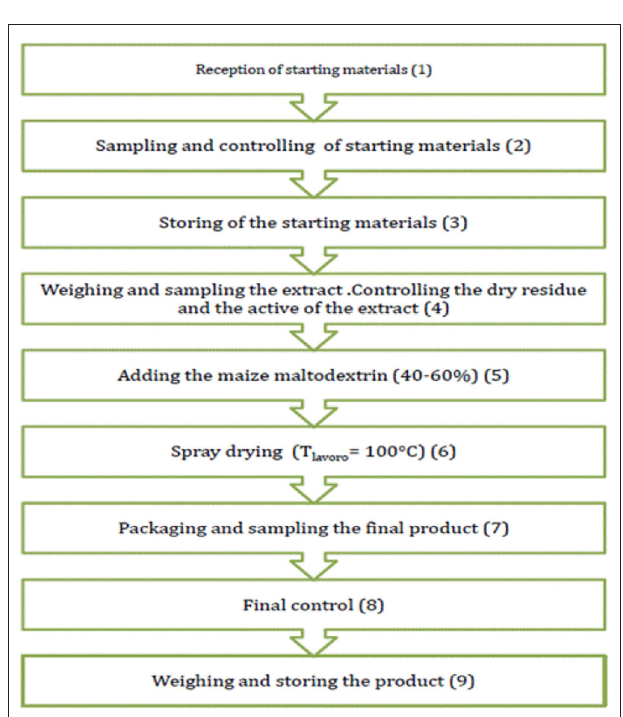
FIGURE 2 | Drying process flow